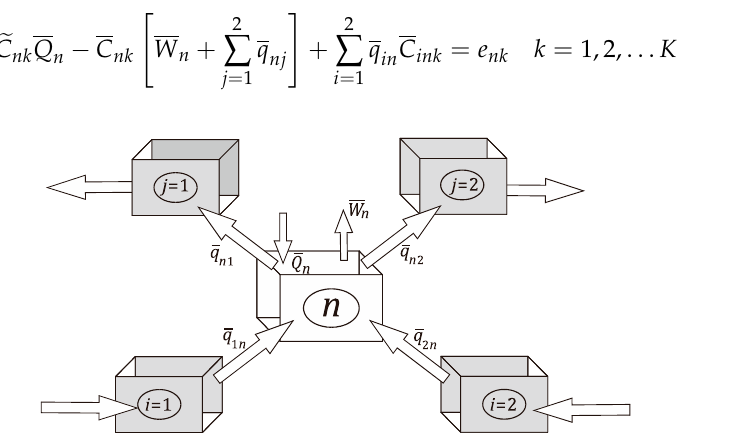
Figure2. A schematic for the mass conservation equation construction. Figure 2. A schematic for the mass conservation equation